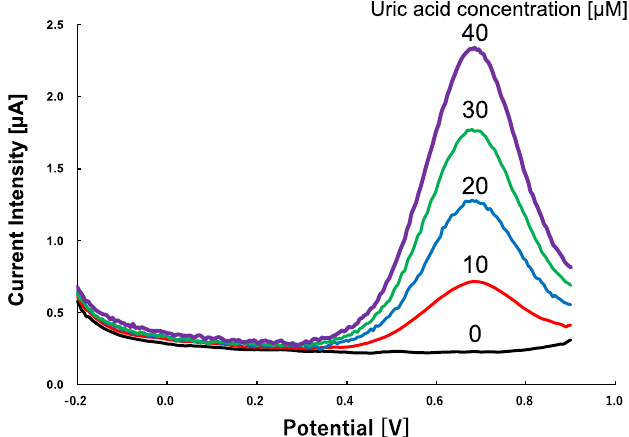
Figure 10. Differential pulse voltammogram of uric acid at the MIP-ITO using ACPF.